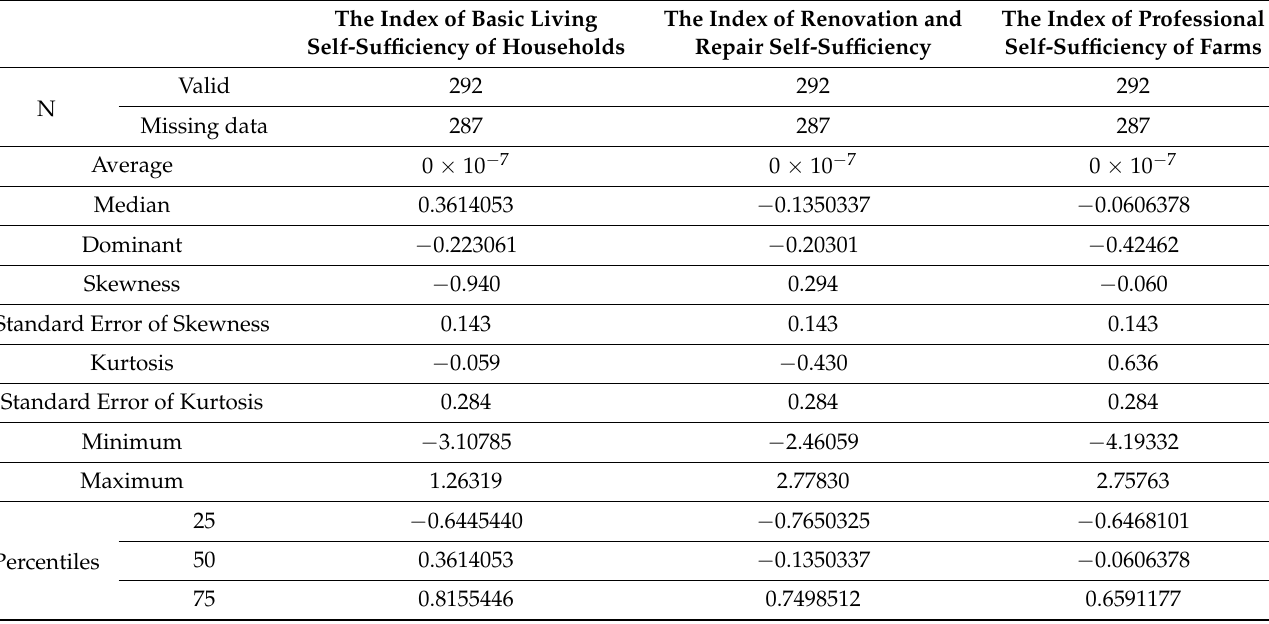
Table 7. Descriptive statistics for separated three components.